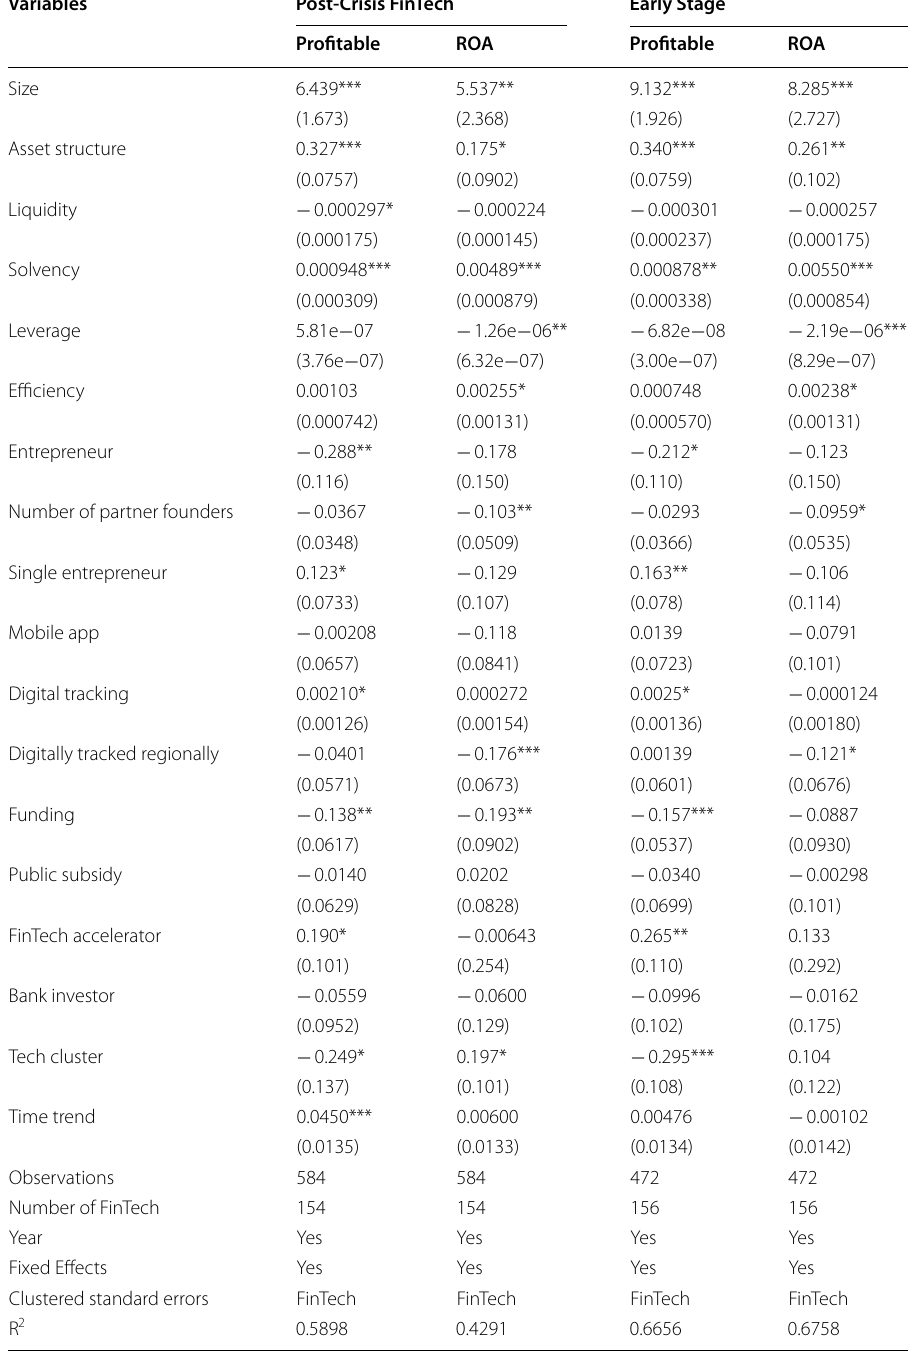
Table 10 Robustness: post‑crisis FinTech companies and early